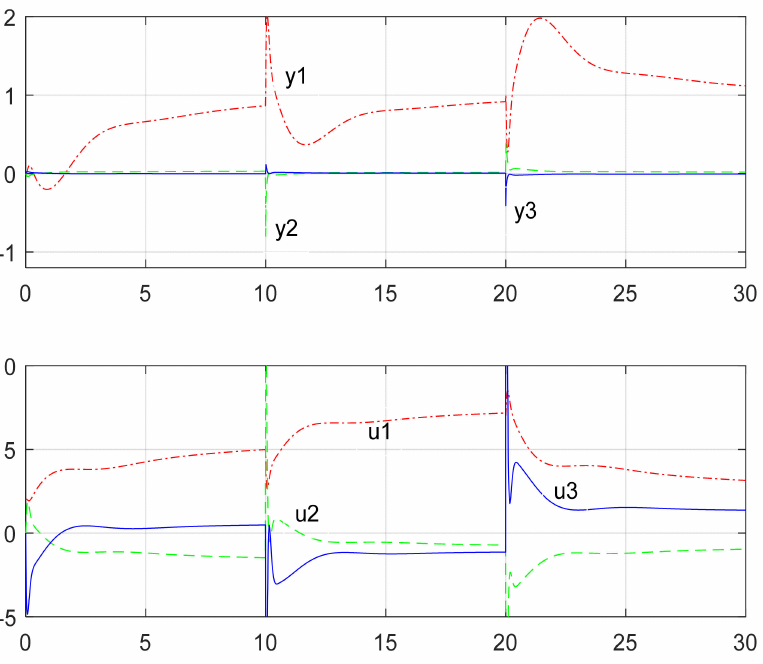
Figure 7. Inconsiderate reference tracking and disturbance regulation. Upper plot shows the system outputs y 1 , y 2 and y 3 as functions of time. Lower plot shows the system inputs u 1 , u 2 and u 3 as functions of time. The references in Figure 1 are r 1 = 1 and r 2 = r 3 = 0. The output disturbances in Figure 1 are are d 1 = 0, d 2 = − σ ( t − 10 ) and d 3 = − 0.5 σ ( t − 20 ) , where σ ( t ) is the unit step function (rather distribution) at time t =